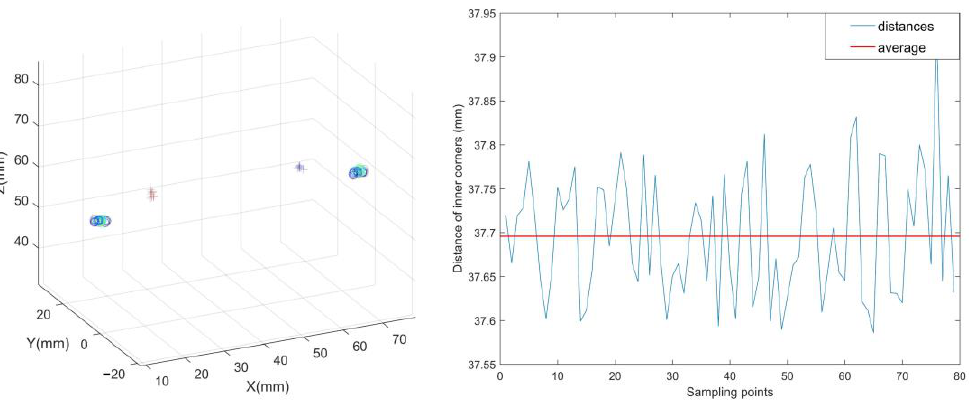
Figure 8. The ( left ) graph represents the extraction result of inner eye corner and centers of eyes in 80 replications. The ( right ) graph shows the distances from the left to right eye corners in the experiment.